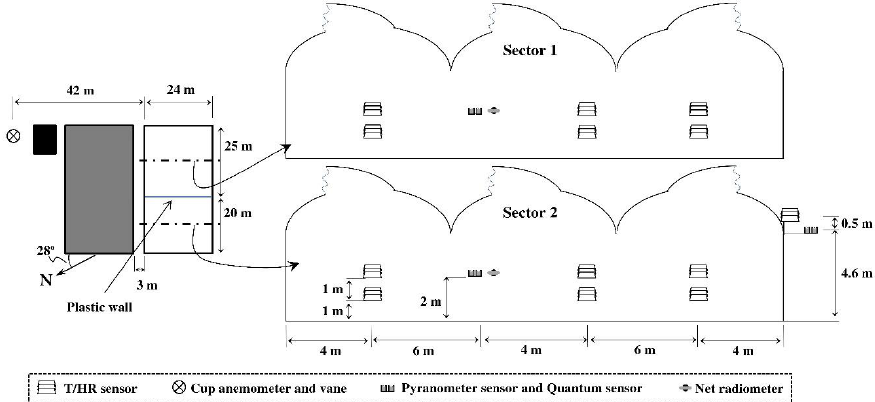
Figure 1. Position of the greenhouse at the experimental farm and location of the sensors. (Adapted of López et al. [16]).